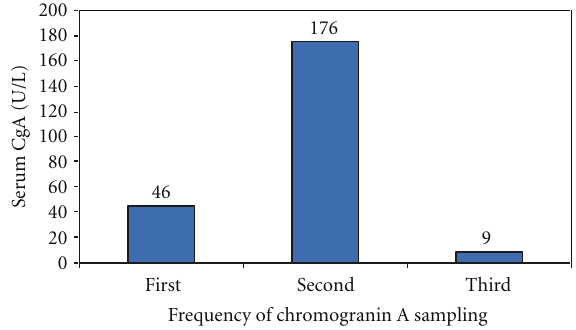
Figure 1: Marked escalation of serum chromogranin A levels 4 months after initial sampling on proton pump inhibitor rapid nor- malisation after 3 weeks of its withdrawal.